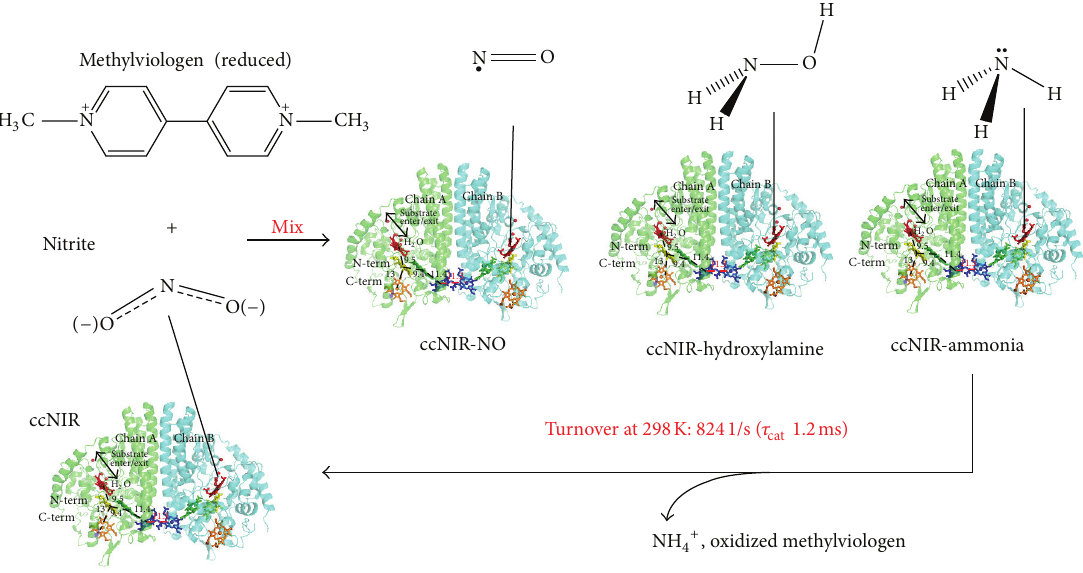
Figure 1: Catalytic cycle of the ccNIR. Initially, nitrite binds to a specific c-heme in the ccNIR. Methylviologen serves as electron donor for the 6-electron transfer reaction to produce ammonia from nitrite. The NO, hydroxylamine, and ammonia complexes are shown. The catalytic rate is 824 1/s at room temperature.